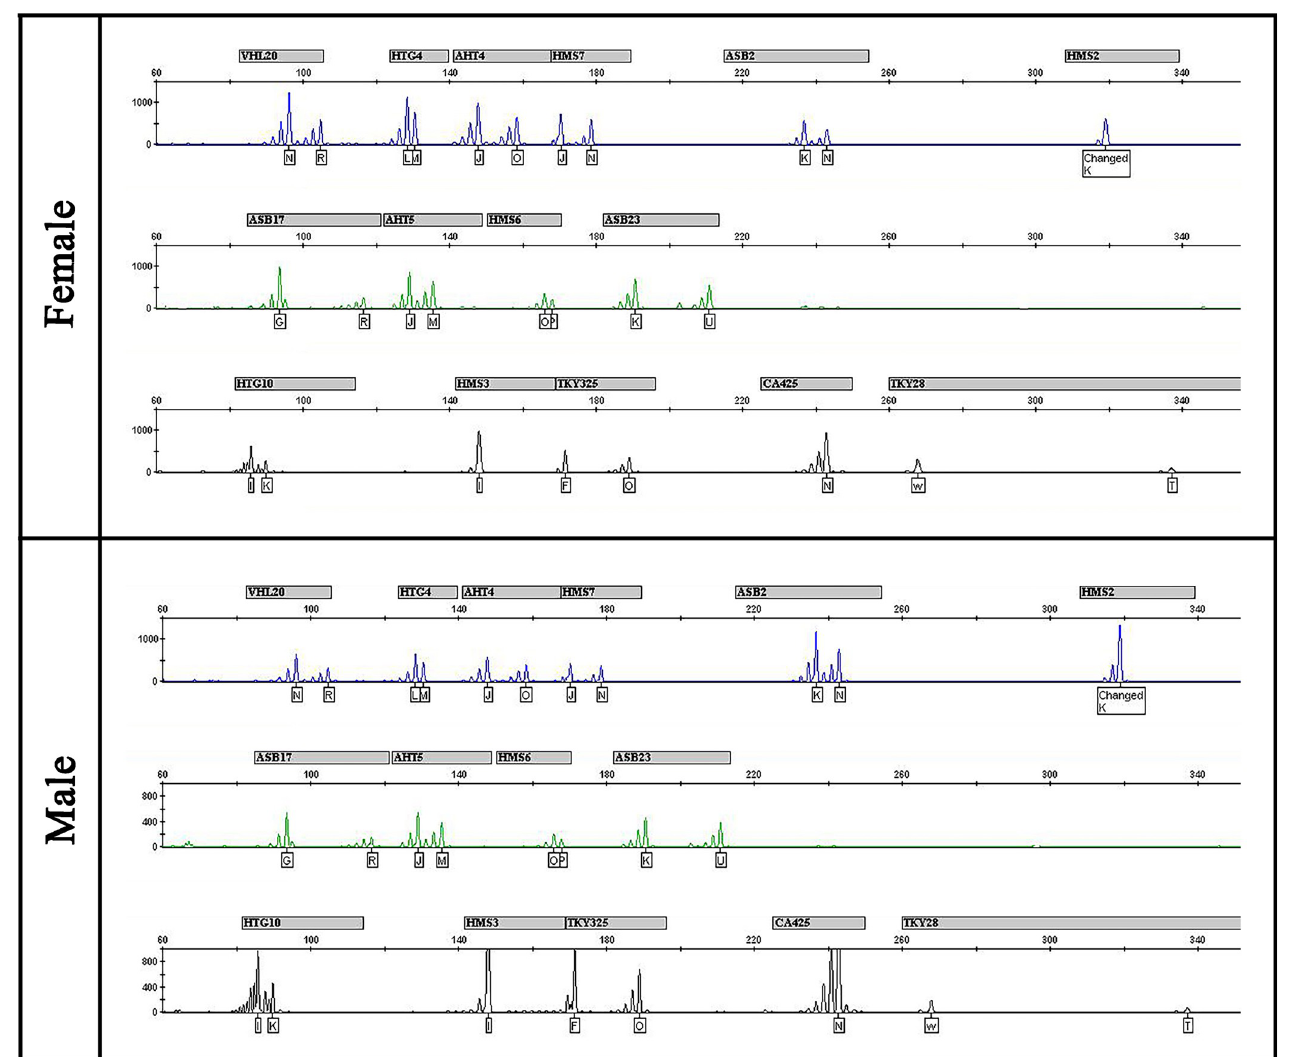
Fig 2. Microsatellite profiles from the foals. Results from the analysis of a 15-panel of microsatellites, used for routine parentage and identity purposes.